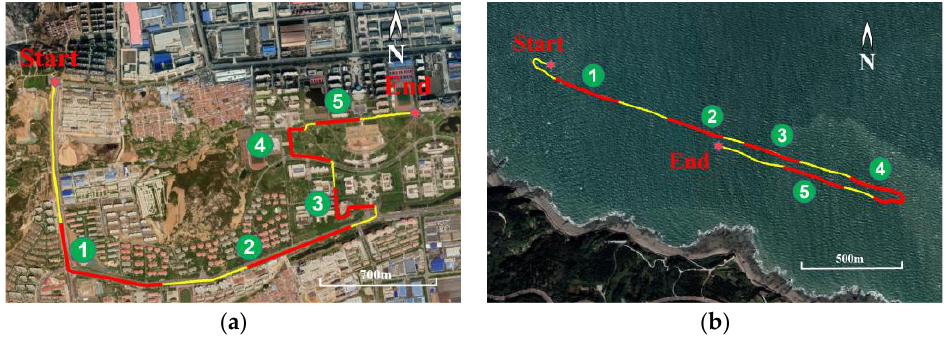
Figure 8. Trajectories of the experiments: ( a ) on land; ( b ) offshore.